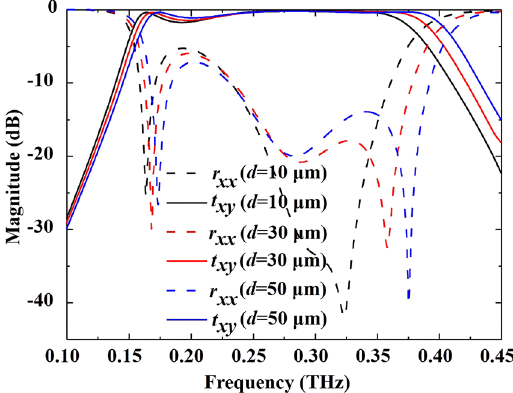
Figure 7. Simulated transmission ( t xy ) and reflection ( r xx ) coefficients for different d in the double L -shaped metasurface when other parameters are fixed. The solid lines correspond to t xy , and the dashed lines are r xx